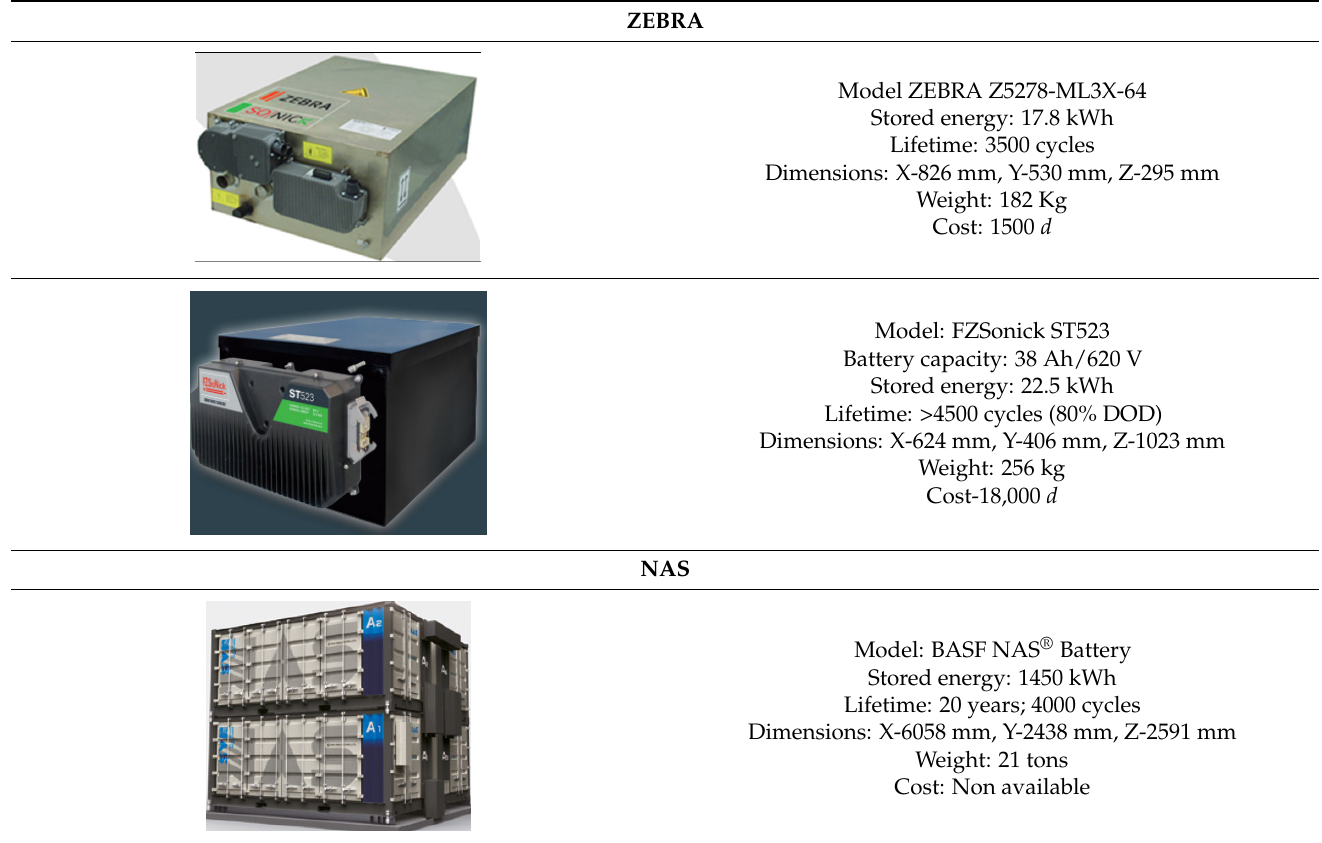
Table A2. Commercial examples of Molten Salt batteries. Data provided by the manufacturer. ZEBRA